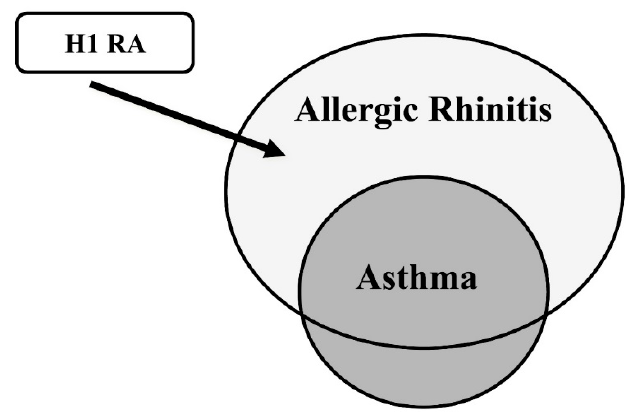
Figure 7. The therapeutic use of H1RAs to the comorbidity of asthma and allergic rhinitis. More than 60% of asthmatics represented the comorbidity with allergic rhinitis.